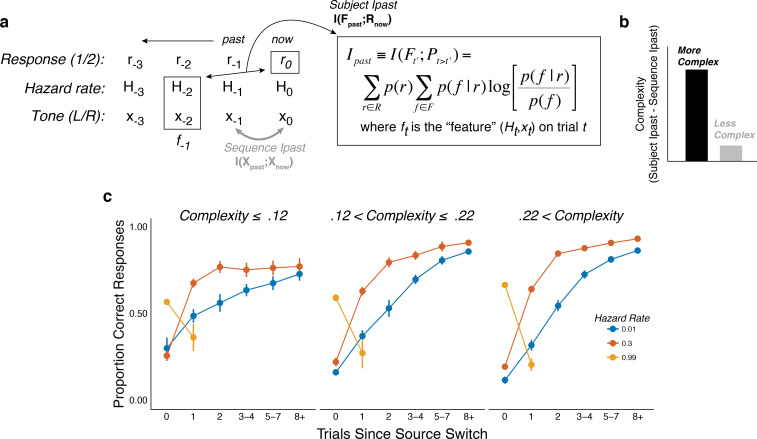
The subjects differed in belief-updating complexity.(a) The information-bottleneck measure of complexity, computed as the mutual information between past task features (the combination of the binary tone location, x, and hazard rate, H, from previous trials) and the current binary prediction, r. (b) To account for idiosyncratic differences in the sequences of tones that each subject heard, the mutual information between adjacent tones in the actual sequence (‘Sequence Ipast’) was subtracted from their respective model complexity. The result corresponds to the degree to which subjects encoded hazard-related information in their predictions. (c) Average task performance plotted for groups of subjects split by complexity tercile (in bits). Subjects with more complex belief-updating strategies showed stronger hazard-modulated behavior.